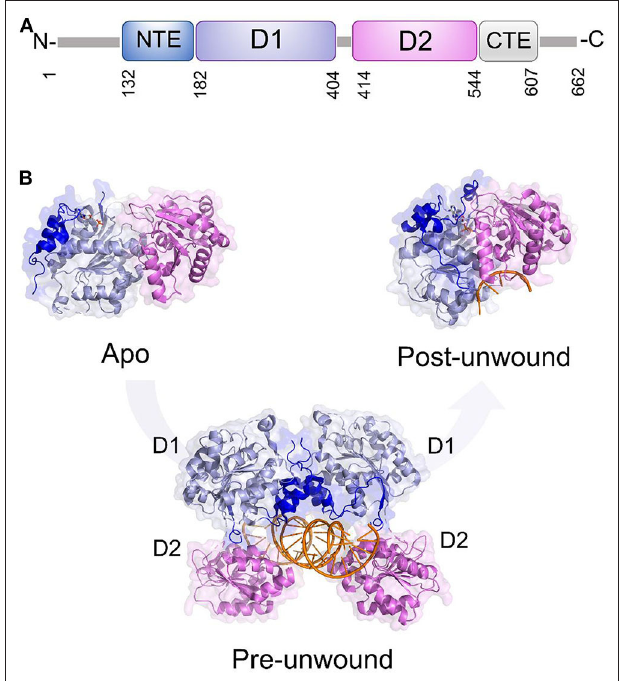
FIGURE 6 | DDX3X as a model for dsRNA unwinding mechanism by DDX helicases. (A) Domain organization and (B) cartoon representation of DDX3X in its proposed functional states, including the apo and pre-unwound states (pdb codes 5e7i and 6o5f, respectively), and its post-unwound state (pdb code: 2db3, ortholog from Drosophila melanogaster ).